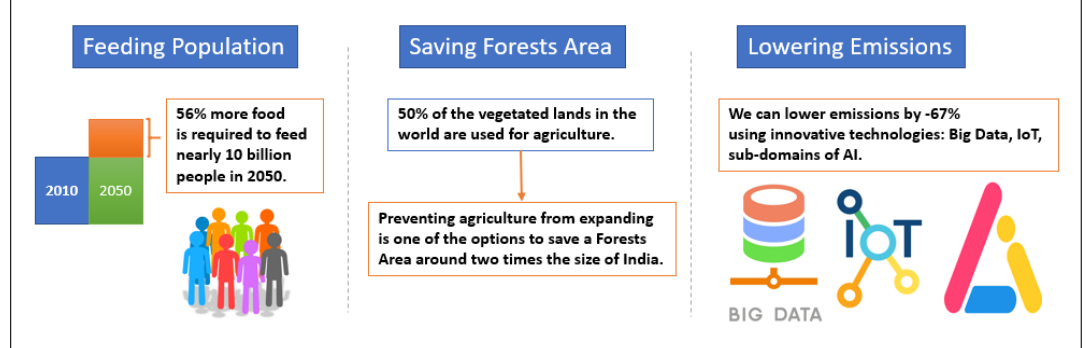
Figure 1. Major smart agriculture challenges.